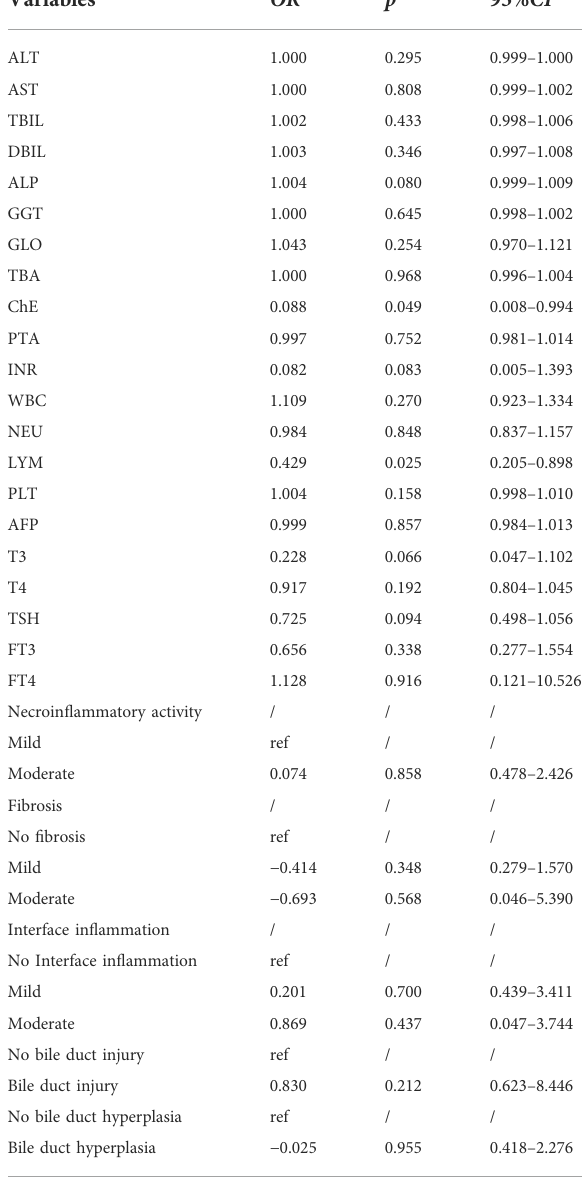
TABLE 3 Baseline data univariate logistic regression analysis.